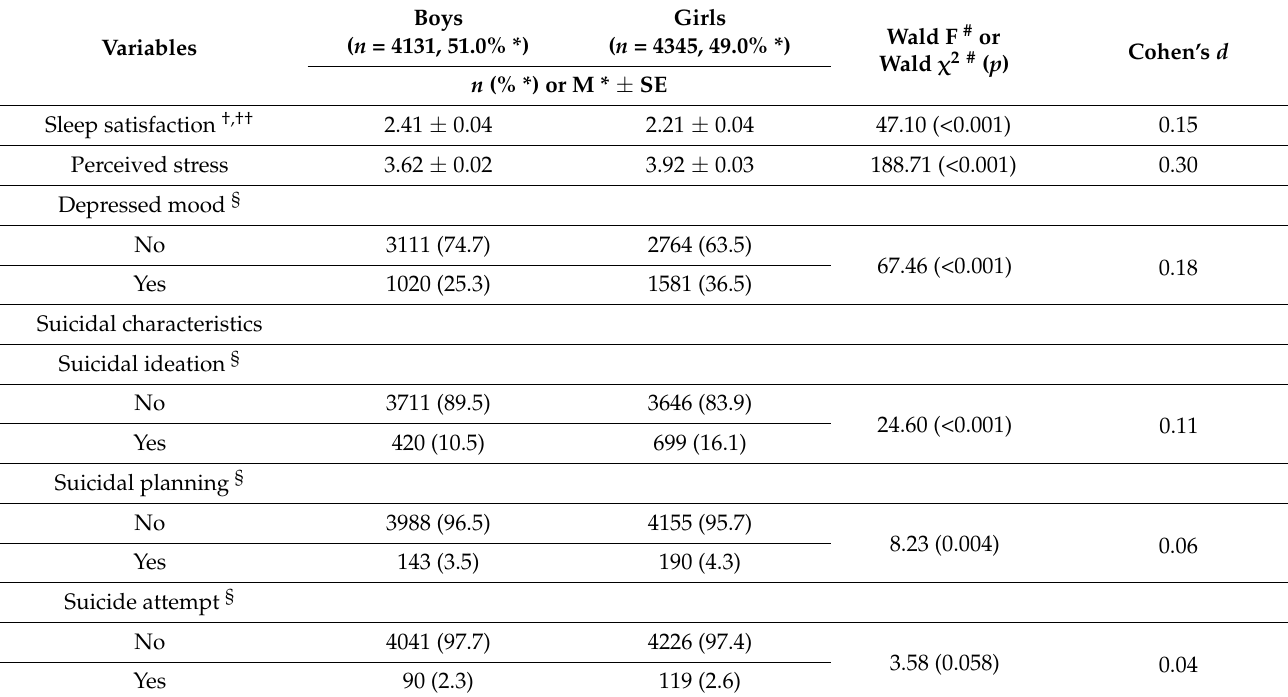
Table 3. Differences in mental health according to gender ( n =